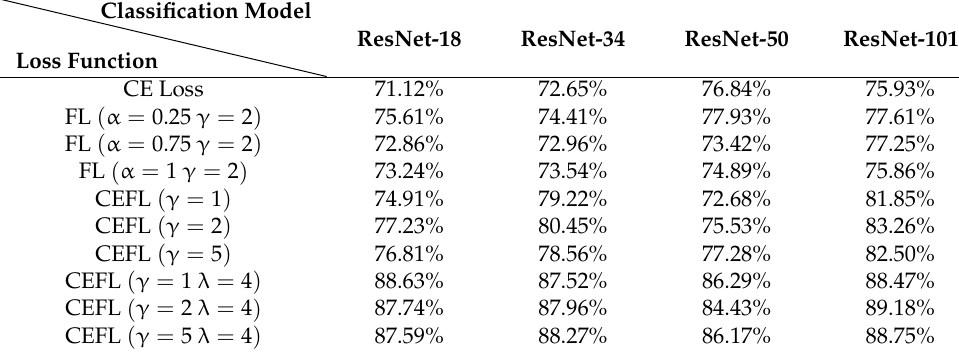
Table 6. F1-score based on different loss functions of various